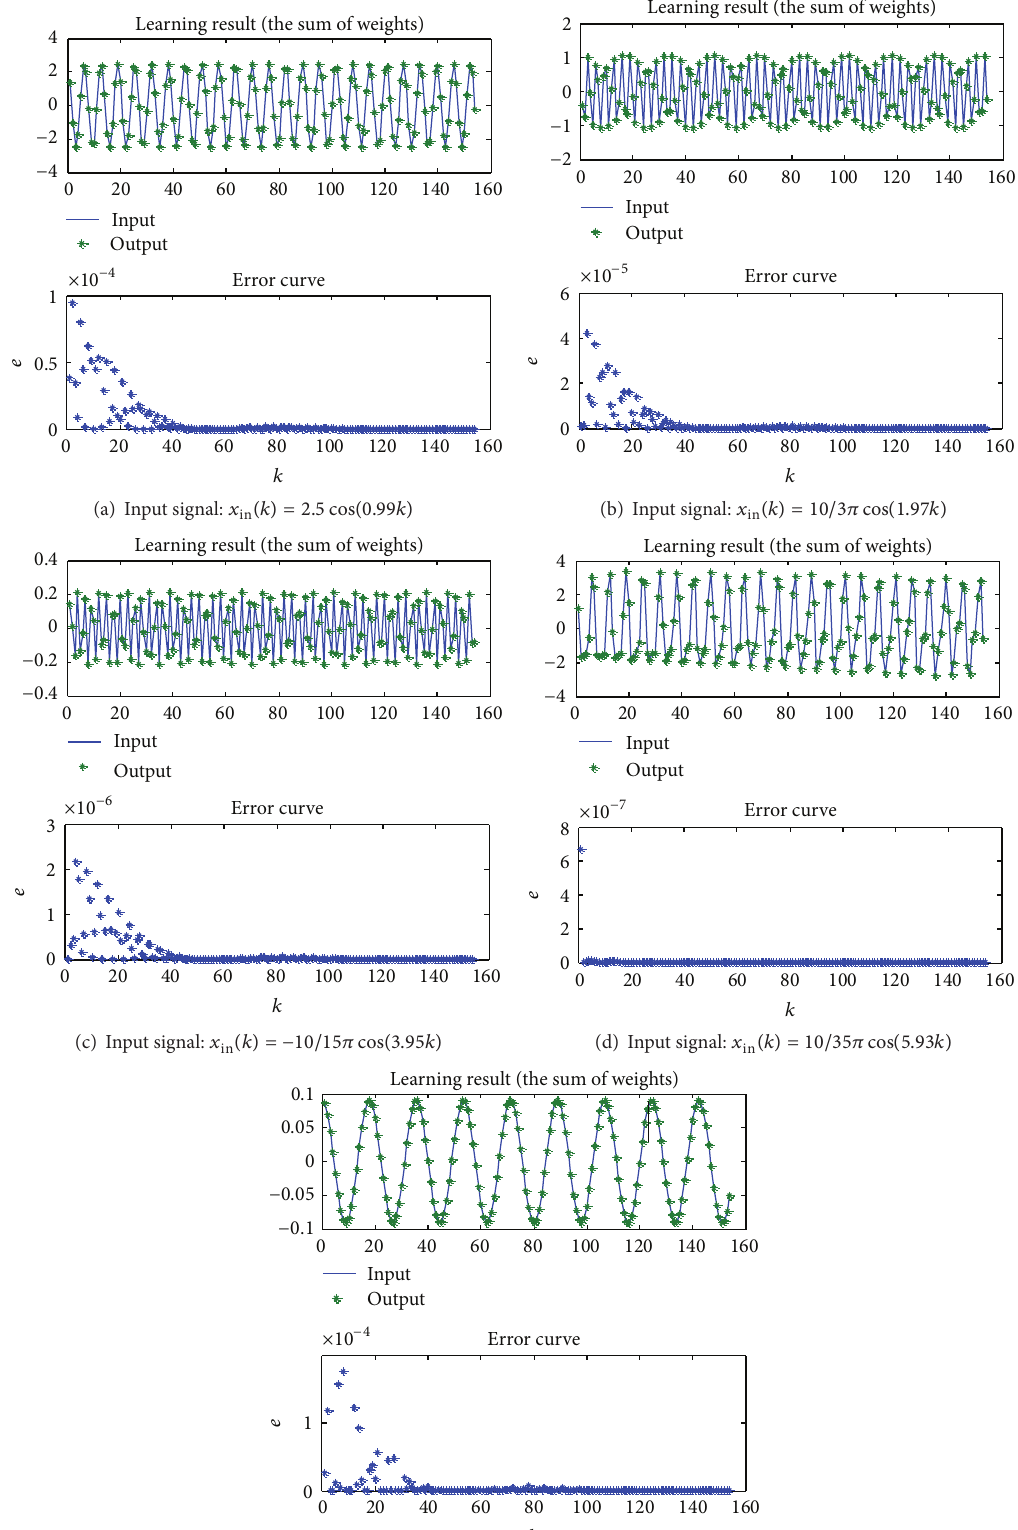
Figure 8: Signal identification plot of PID controller based on memristive